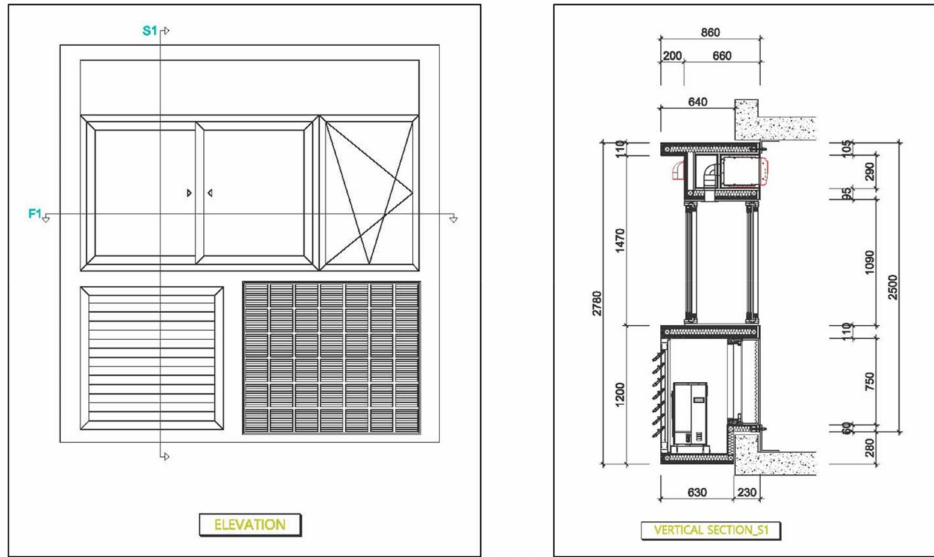
Figure 2. Front view and section of the envelope.